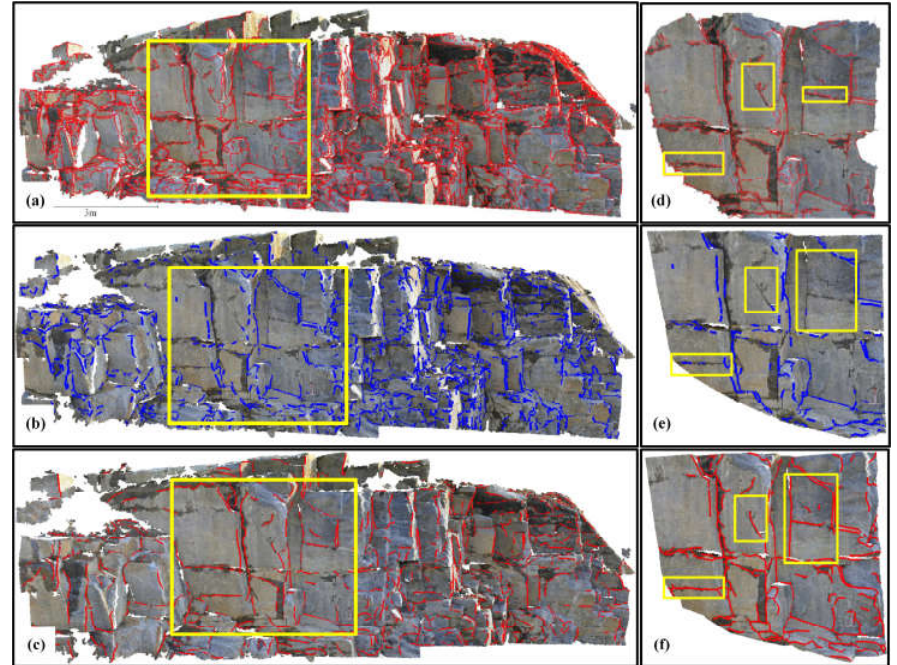
Figure 20. Case C: Comparison between the proposed method and existing methods. ( a ) Disconti- nuity traces extracted using only texture attributes; ( b ) discontinuity traces extracted using tensor voting and geometric attributes; ( c ) discontinuity traces extracted using the proposed method with both geometric and color attributes; ( d – f ) detailed results of the different methods.